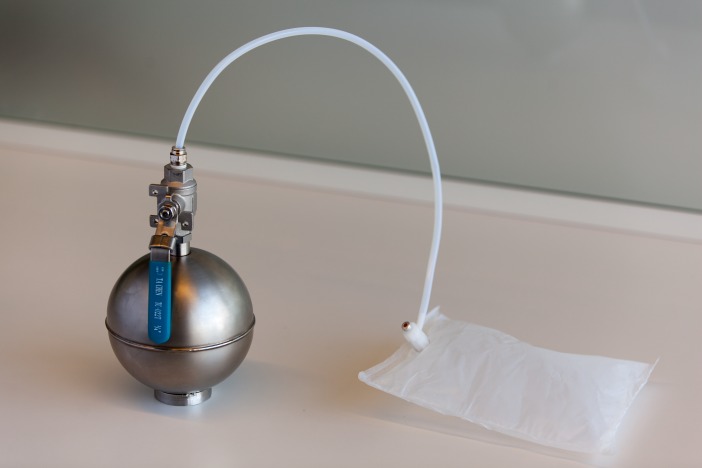
Stainless steel evaporation chamber used for transferring diluted n-butanol to a Tedlar bag.